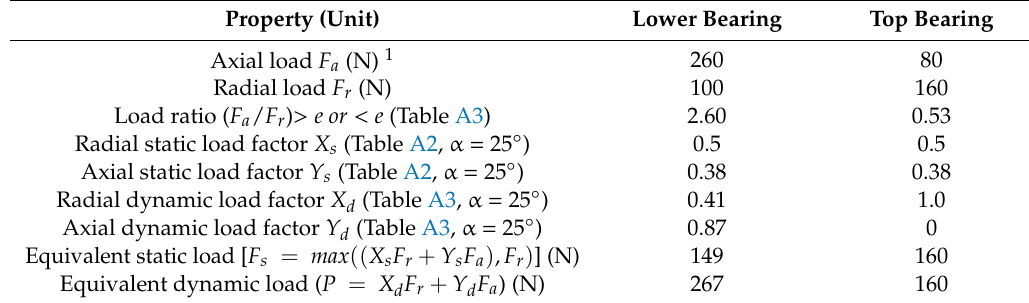
Table 3. Bearing specifications and static and dynamic loads.